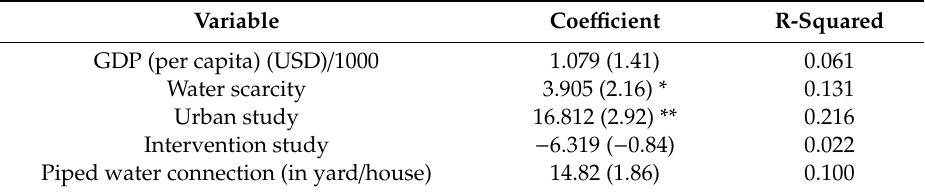
Table A5. Exploratory bivariate regression models, of reported LPCD and each explanatory variable, based on a subset of studies ( n = 33) published between 2000 and